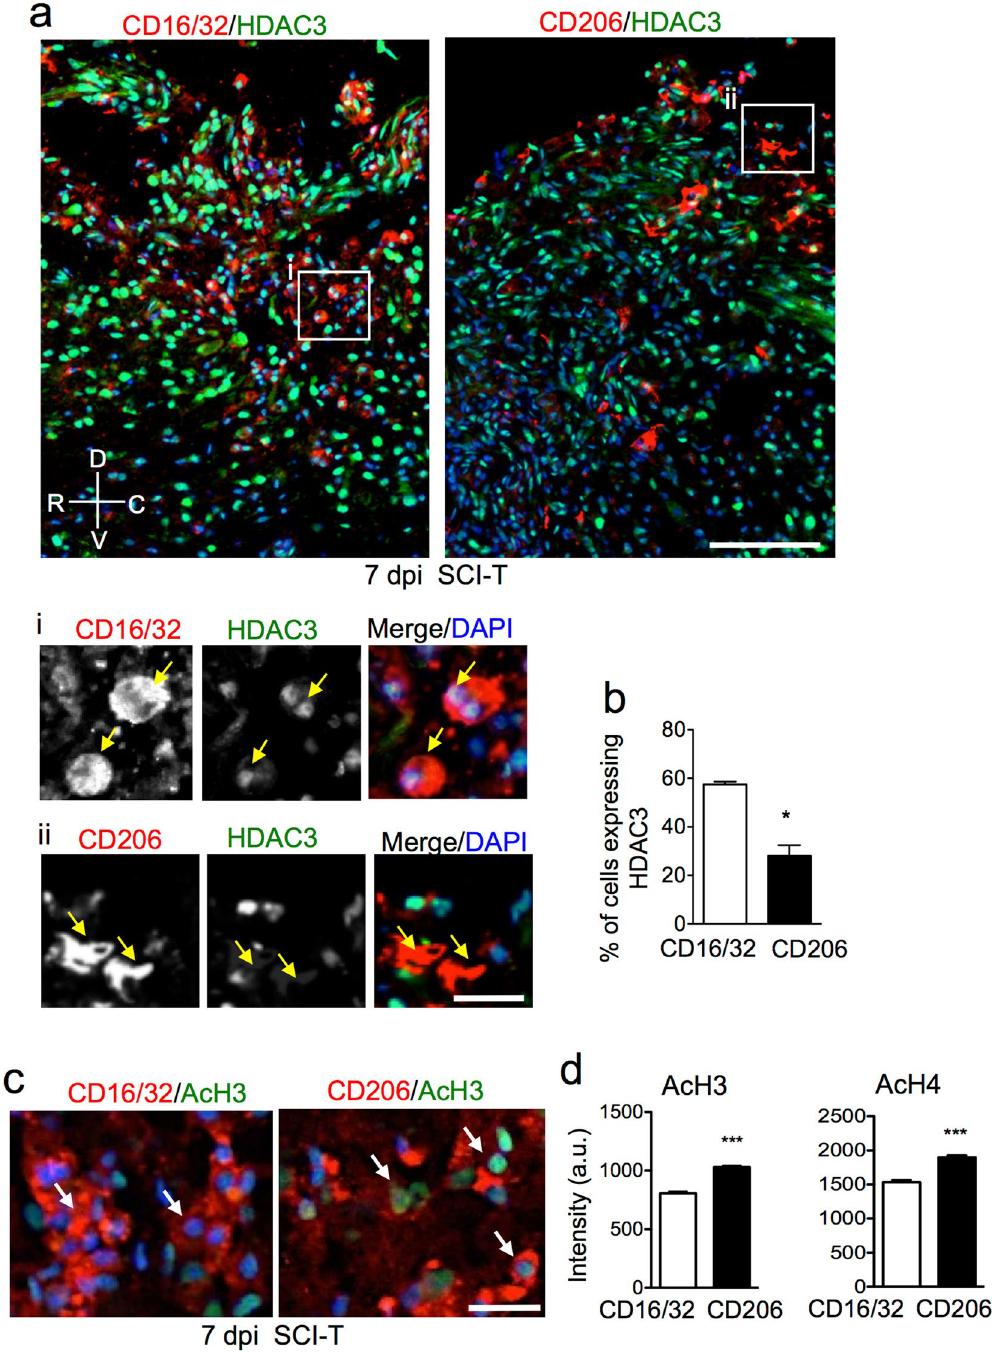
Figure 2. Upregulation of HDAC3 correlates with decreased histone acetylation level. ( a , b ) Representative images and quantification of co-immunolabeling for cell surface markers (red) and HDAC3 (green) at the lesion center 7 days post T8 dorsal column transection (SCI-T). Enlarged images of boxed areas (i and ii) are shown below. Arrows point to nuclear HDAC3 immunoreactivity. * p = 0.024, parametric split-plot ANOVA, n = 3 pairs of mice, with three representative image for each animal. ( c , d ) Representative images and quantification of co-immunolabeling demonstrate that CD206 + macrophages (red) display higher levels of AcH3 (green) than CD16/32 + macrophages (red), as well as higher levels of AcH4 ( d ). For AcH3 levels, 3029 CD16/32 + cells and 6245 CD206 + cells from 3 animals, with 3 images from each animal were quantified. For AcH4, 1687 CD16/32 + cells and 2305 CD206 + cells from 3 animals, with 3 images from each animal were quantified. *** p < 0.001, Mann Whitney test. Orientation: R: Rostral, C: Caudal, D: Dorsal, V: Ventral. Scale bars: 100 µ m ( a ), 25 µ m (insets i and ii), 20 µ m ( c